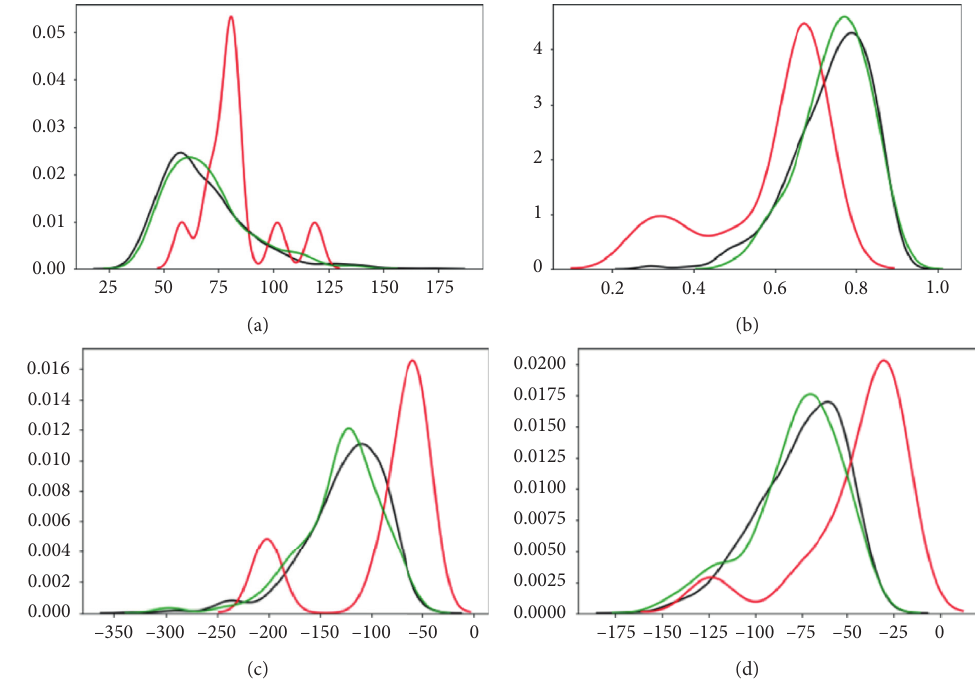
Figure 6: Distribution of four indexes: (a) the L -norm index between generated signals and actual signals; (b) the CORT index between 2 generated signals and actual signals; (c) the fake-level score of actual signals; (d) the fake-level score of generated signals. Table 5: The comparisons of different machine learning methods. Table 4: The comparison results of different index settings. Method W -recall W -precision W - Index W -recall W -precision W - F